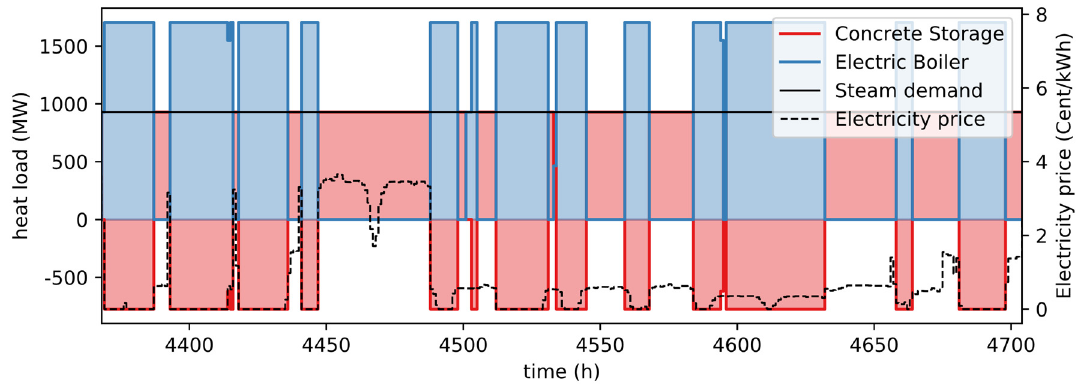
Figure 12. Storage and steam generator loads, steam demand and electricity price profiles for Case 1 during wet season.